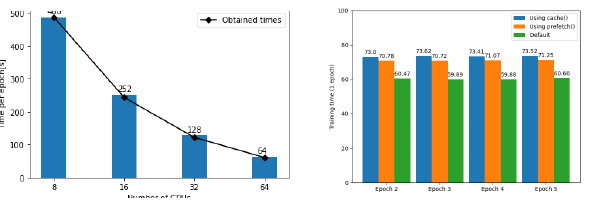
Figure 6. (left) Microsoft Azure training time per epoch for a BS = 64 batch size. (right) Azure ML service automatic optimisation performance compared to manual cache and prefetch implementation. All times are measured in seconds. Figure 5. (left) The impact of increasing number of total GPUs assigned to workers on time to process one epoch of training. (right) Cost of running one epoch on the Google Cloud Platform. The cost per epoch remains similar for all GPU combinations, though the training time improves almost linearly.